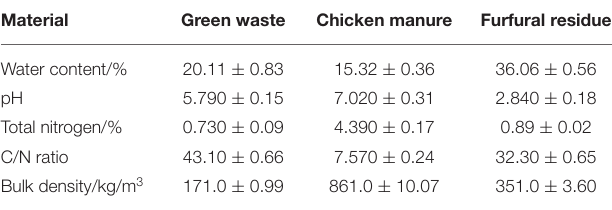
TABLE 1 | Basic physical and chemical properties of composting materials.